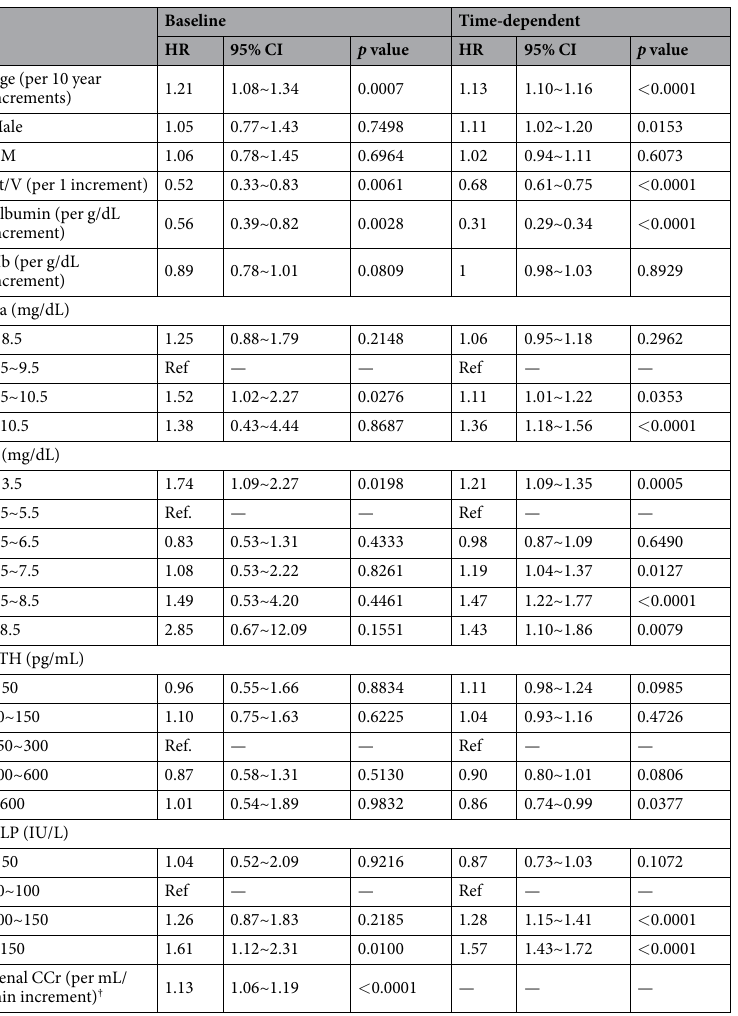
Table 3. Multivariate Cox proportional hazard ratio of mortality in which PTH, ALP, calcium and phosphorus were considered as categorical variables. PTH, parathyroid hormone; ALP, total alkaline phosphatase; HR, hazard ratio; CI, confidence interval; DM, diabetes mellitus; Kt/V, weekly Kt/V; Hb, hemoglobin, Ca, total calcium; P, phosphorus; renal CCr, renal creatinine clearance. † Renal creatinine clearance was not included in the time-dependent analysis due to large number of missing baseline values (n =